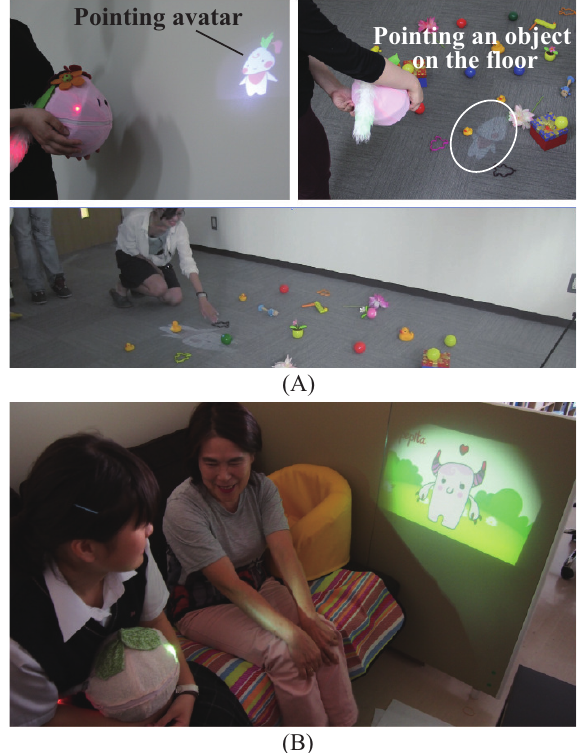
Figure 14. Enhancing the robot’s expressiveness with projected images: ( A ) avatars to make pointing gestures using the robot in remote communication; ( B ) scenario of a robot sharing information with multiple users in the same place and